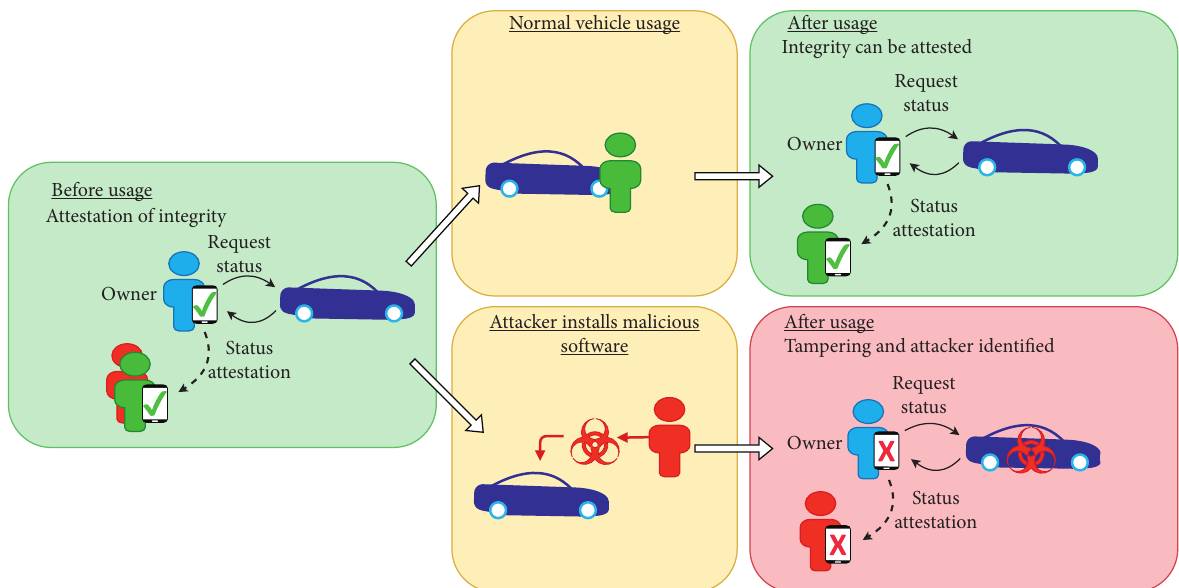
Figure 1: Considered scenario with normal usage on the car and an attacker which installs malicious software. The software manipulation can be detected afterwards by using